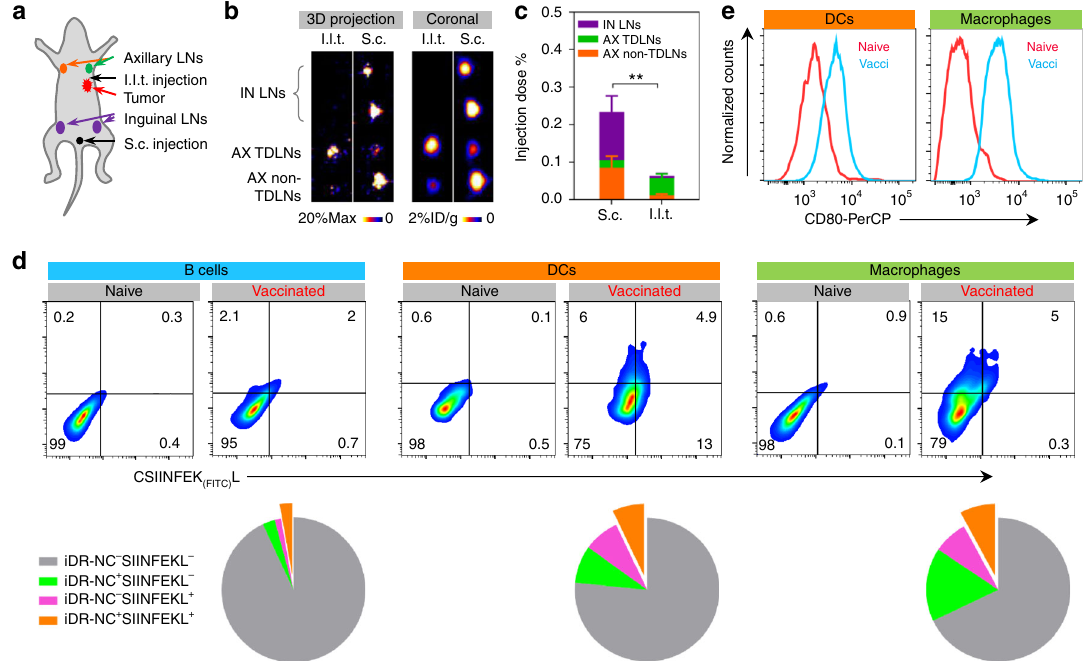
Fig. 6 Ef fi cient delivery of iDR-NCs to LN APCs in vivo. a Schematic illustration of the LN delivery study of iDR-NCs. b , c Representative 3D projection and coronal PET views b and ID% c of 64 Cu-labeled iDR-NCs in LNs one day after i.l.t. or s.c. injection. d Upper: representative fl ow cytometry plots showing the signals of Alexa 555-labeled iDR-NCs and CSIINFEK (FITC) L in LN-residing B220 + B cells, CD11c + DCs, and F4/80 + macrophages one day after s.c. injection at the tail base of C57BL/6 mice. Lower: pie charts showing the quanti fi ed fl ow cytometry results in vaccinated mice. ( n = 4 in a – d ; ** p < 0.01; one-way ANOVA with Bonferroni post-hoc test). Data represent mean ± s.e.m. e Flow cytometry results showing elevated CD80 expression in LN DCs and macrophages one day after s.c. vaccination (vacci.) of iDR-NCs in C57BL/6 mice. Age-matched naive mice were used as controls in b ,